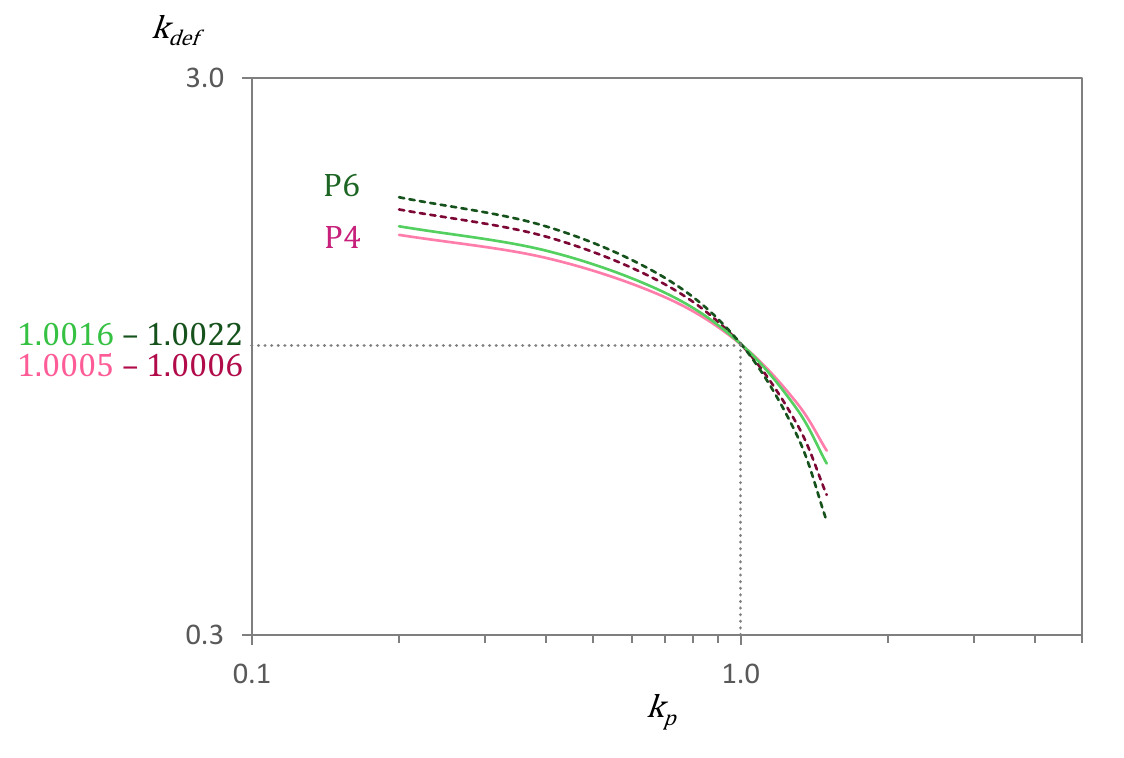
Figure 10. Graphical representation of k def ( lim ) for cement pastes P4 and P6 after 6 h of capillary imbibition in water (for k tot = 1.0003 and 1.0009 for P4 and P6, respectively). Full and dotted lines represent the limits of the k def ( lim ) interval.